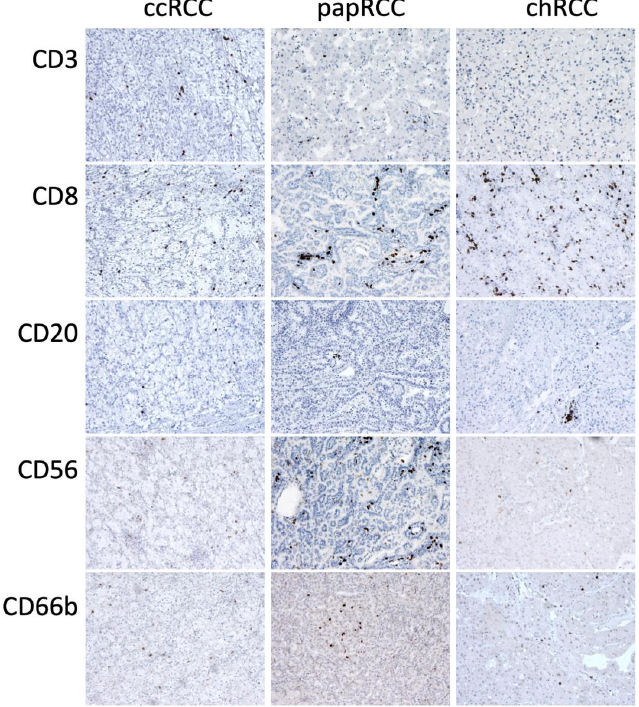
Figure 6. Immunohistochemical staining of RCC samples for CD3, CD8, CD20, CD56 and CD66b. Magnification is 400×. Analysis of the association of immune cell content in the tumor stroma with the clinical and morphological characteristics of patients was performed (Table 4). Table 4. Association of the content of CD68, PU.1, CD163, CD66b, CD56, CD20, CD3, CD8, FoxP3 positive cells in the stroma with the histological type of tumor and stage of the disease (median 25 – 75%). Histology